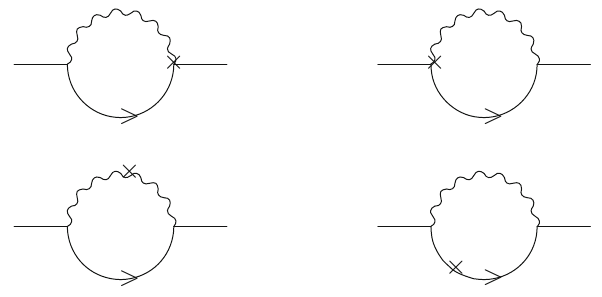
Fig. 1 One loop corrections induced from the non-minimal LV oper- ators given in Eq.(48), where the cross indicate a LV insertion. We consider only contributions of first order in LV